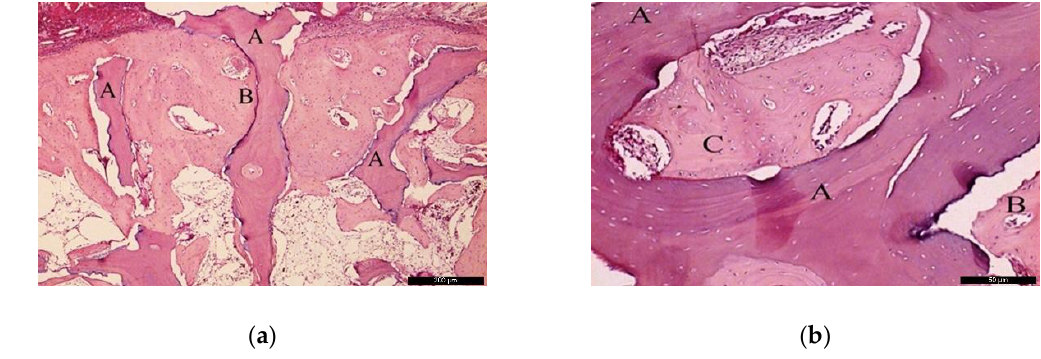
Figure 6. Histological analysis of the BG at 60 days. ( a ) Biomaterial (A) enwrapped by newly formed bone (B). Hematoxylin and eosin stain at a magnification 40 × ; ( b ) Biomaterial (A) on the recipient bed (B), and newly formed bone (C). Hematoxylin and eosin stain at a magnification 125 ×.